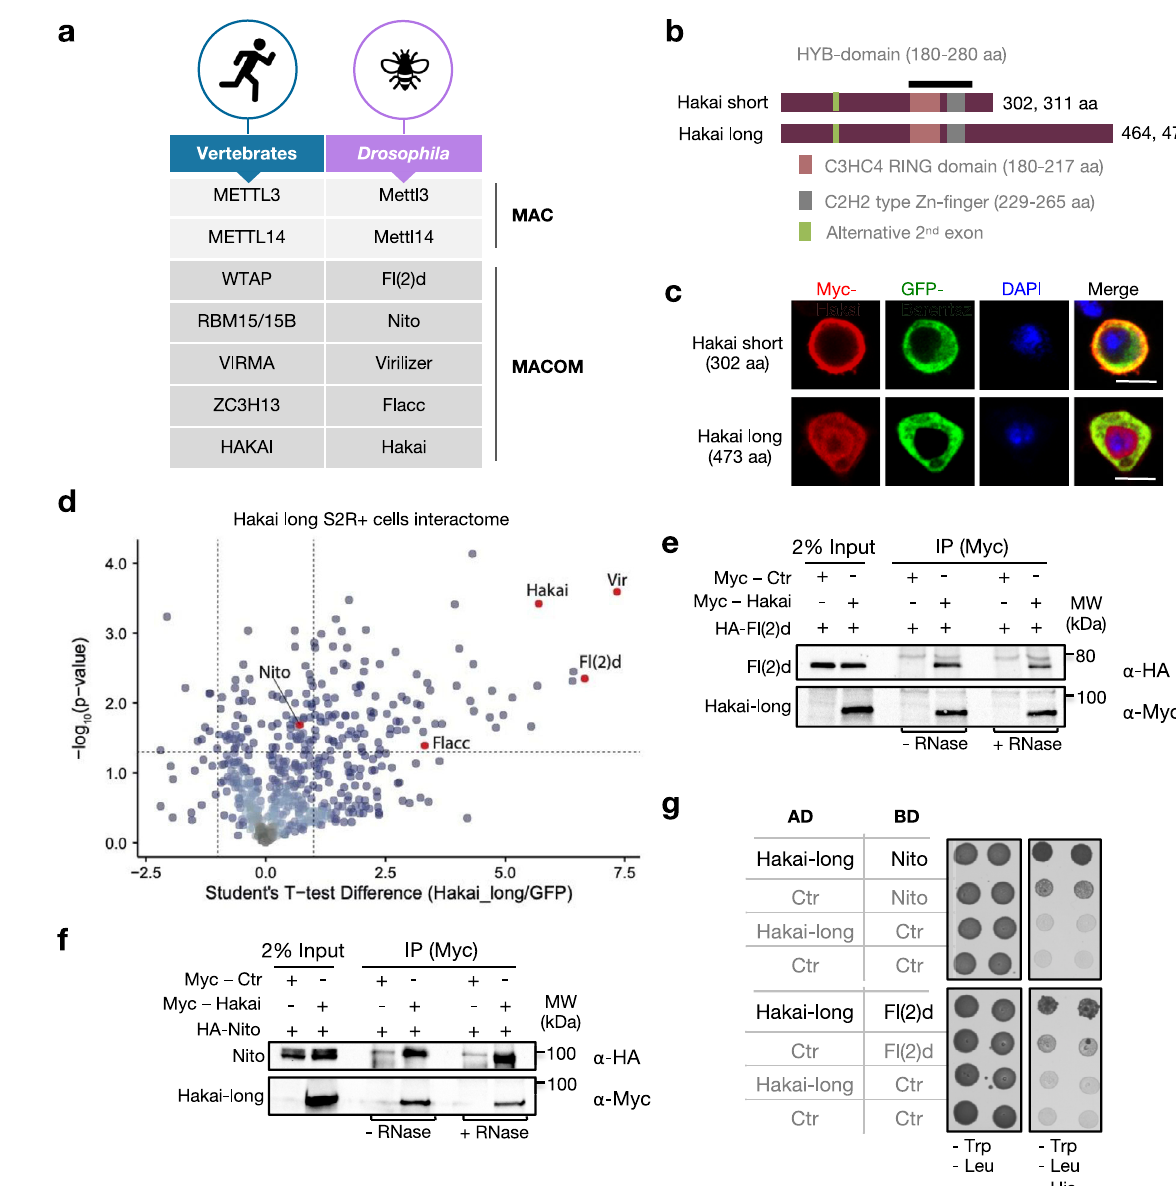
Fig. 1 Hakai interacts with MACOM components. a Table indicating the names of MAC and MACOM components in Vertebrates and Drosophila . b Schematic of the Hakai short and long protein isoforms depicting the RING domain (pink), the Zn- fi nger (grey) and the HYB domain (black). The green domain indicates the alternative region of the second exon that is included in isoforms 311 aa and 473 aa. c Immunostaining of Myc-tagged Hakai short and long protein isoforms overexpressed in S2R + cells. GFP-tagged Barentsz protein served as a cytoplasmic marker. DAPI staining is shown in blue. The short Hakai isoform localizes strictly to the cytoplasm, whereas the long isoform localizes to both cellular compartments with the enrichment in the nucleus. Scale bars, 10 μ m. d Identi fi cation of proteins interacting with GFP-Hakai-long in S2R + cells based on label-free analysis of two replicate experiments analyzed by quantitative MS-based proteomics. HAKAI immunoprecipitates alongside of all MACOM components. MACOM component proteins are highlighted in red. A complete list of quanti fi ed proteins can be found in Supplementary Data 2. e , f Co-immunoprecipitation experiments were carried out with lysates prepared from S2R + cells transfected with Myc-tagged Hakai (long isoform) and HA-tagged Nito or Fl(2)d. In control lanes, S2R + cells were transfected with Myc alone and an identical HA-containing protein. Extracts were immunoprecipitated with anti-Myc antibody and immunoblotted using anti-Myc and anti-HA antibodies. Two percent of input was loaded. The same experiment was repeated in the presence of RNase T1. Nito and Fl(2)d interact with Hakai in an RNase-independent manner. Blots shown are representative of one biological replicate. g Yeast-two-hybrid assay to investigate Hakai interaction with Nito and Fl(2)d. Proteins were cloned in yeast expression vectors and fused with either Gal4-DNA binding domain (BD) or Gal4- DNA activation domain (AD). Indicated combinations of vectors were co-expressed in yeast and empty vectors encoding only activation or binding domain were used as control (Ctr). Recovered colonies were spotted on plates lacking Leucine and Tryptophan (-Leu, -Trp) as well as selection plates lacking amino acids Leucine, Tryptophan and Histidine (-Leu, -Trp, -His). AD-Hakai long isoform interacts with BD-Fl(2)d and BD-Nito. Source data for Western blots and the yeast-two-hybrid assay are provided as a Source Data fi le.